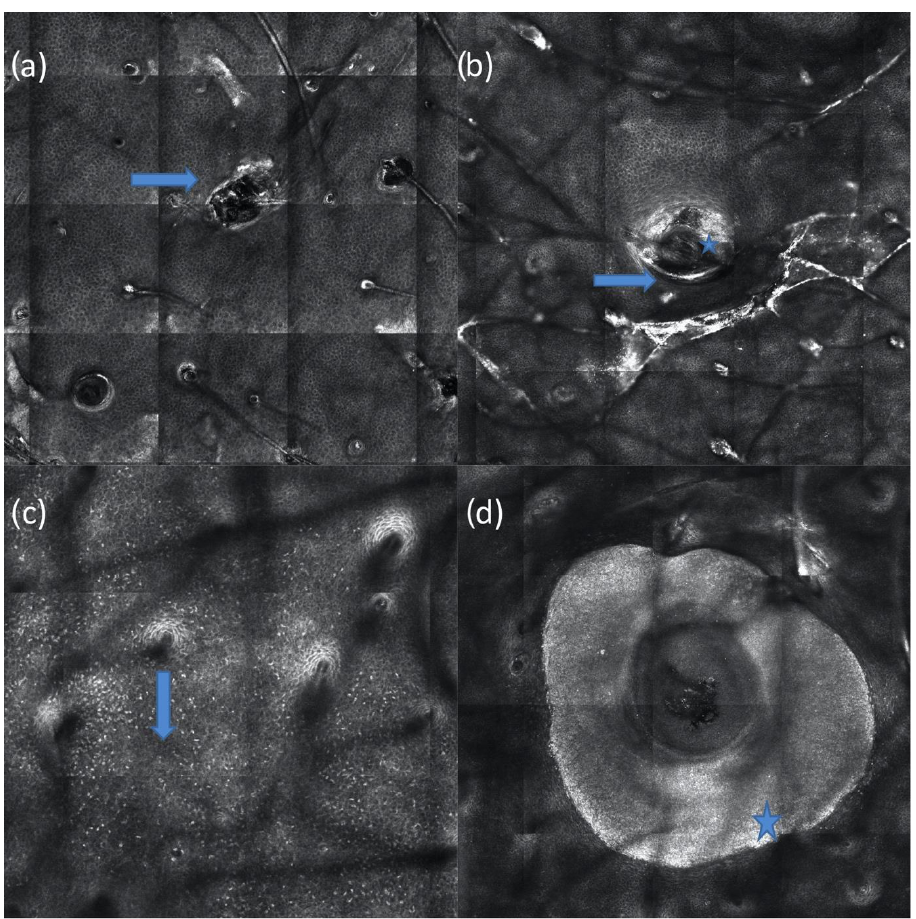
Figure 3. RCM images of a closed comedo (arrow), with well-defined infundibula and thick bright borders ( a ); an open comedo (arrow), with large infundibula and hyper-reflecting irregular borders filled by amorphous material (star) ( b ); a papule, showing an abundant inflammatory infiltrate composed of many sparse hyper-reflecting cells (arrow) at the spinous layer of the epidermis ( c ), and a pustule characterized by the presence of a hyper-reflecting organized inflammatory infiltrate inside the pustular cavity (star) ( d ).